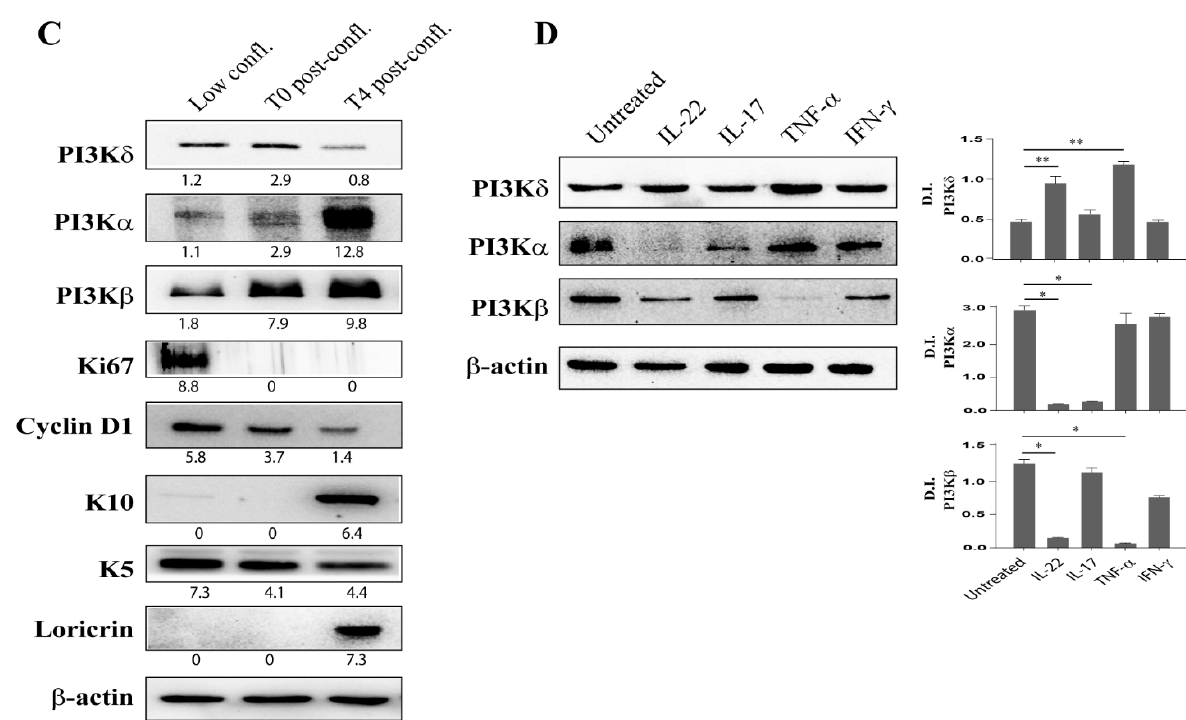
Figure 1. PI3K δ expression is up-regulated in skin of psoriatic patients and in proliferating psoriatic keratinocytes activated by pro-inflammatory cytokines. ( A ) In GSE13355 dataset, the raw data from 180 microarrays were processed using the robust multichip average (RMA) method. The resulting expression values of the PI3K δ , α , and β isoforms enzymes in healthy control (Healthy, n = 64), non-lesional (NLS, n = 58) and lesional (LS, n = 58) psoriatic skin tissues were obtained from RNA-seq dataset (GSE13355). Datasets were obtained from the transcriptome analysis of whole biopsies from lesional (LS) and non-lesional (NLS) psoriatic skin. Data are expressed as mean ± SD. Statistical significance was assessed by paired Student’s t test, * p ≤ 0.001. ( B ) Immunohistochemical (IHC) analyses for PI3K δ and PI3K α (stained in red) were performed on paraffin-embedded sections of biopsies obtained from psoriatic skin ( n = 6), including NLS, lesional LS zones of evolving plaques, and healthy skin. Sections were counterstained with Mayer’s H&E. One out of six representative stainings of psoriatic skin biopsies are shown. Bars, 100 µ m. All panels include 20X high magnifications panels. Graphs show the mean of four-stage score values ± SD for PI3K δ or PI3K α epidermal expression per three different fields of all six sections. * p ≤ 0.05, as assessed by Mann–Whitney U test. ( C,D ) Experiments were conducted on keratinocyte cultures isolated from psoriatic NLS skin ( n = 3 strains) and maintained in different specific culture conditions. ( C ) WB analysis was performed on proliferating keratinocytes (sub-confluent), on confluent (T0) and post-confluent (T4) keratinocyte cultures, resembling different stages of differentiation in order to analyze the expression of PI3K δ , - α , and - β isoforms; K10; Loricrin; K5; Ki67; and cyclin D1 proteins. β -actin was used as loading control. D.I. indicates the densitometric intensity of the indicated protein levels normalized to β -actin levels shown in one representative of three different WB. ( D ) The expression of PI3K δ , - α , and - β isoforms was analyzed by WB on protein homogenates from proliferating keratinocytes left untreated or stimulated with IL-22, IL-17A, TNF- α , or IFN- γ for 6 h. β -actin was used as loading control. Graphs show the mean ± SD of densitometric intensity (D.I.) values of protein levels normalized to β -actin expression. Results were obtained by three independent experiments. * p ≤ 0.05, ** p ≤ 0.01 were assessed by paired Student’s t test comparing untreated and cytokine-treated